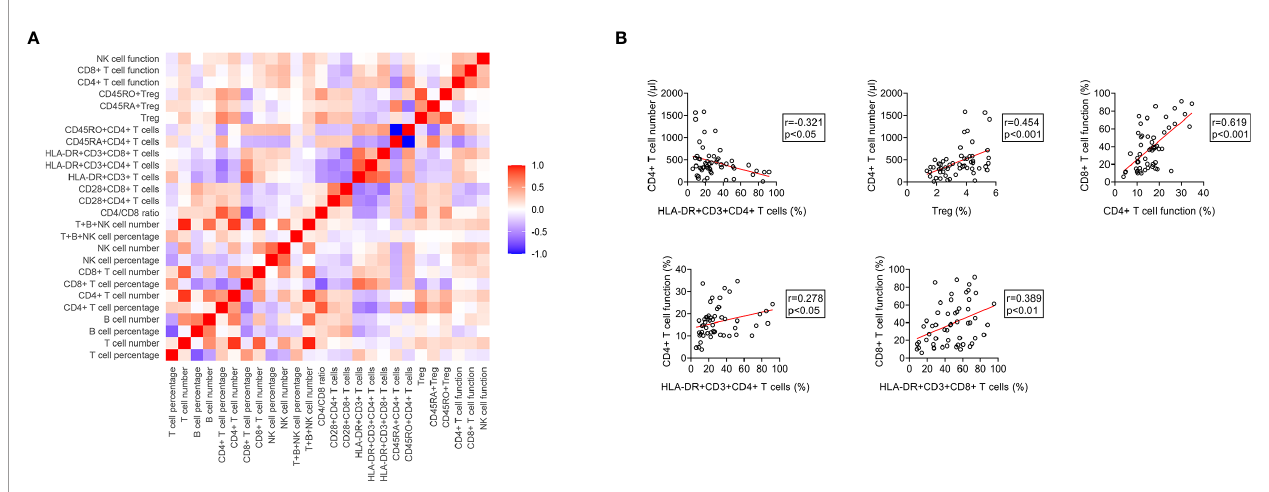
FIGURE 9 | The relationship between different immune indicators in ATB patients. (A) Heatmap showing the relationship different immune indicators in ATB patients. (B) Scatter plots showing the correlation between the number, phenotype, and function of lymphocytes in ATB patients. Each symbol represents an individual donor. ATB, active